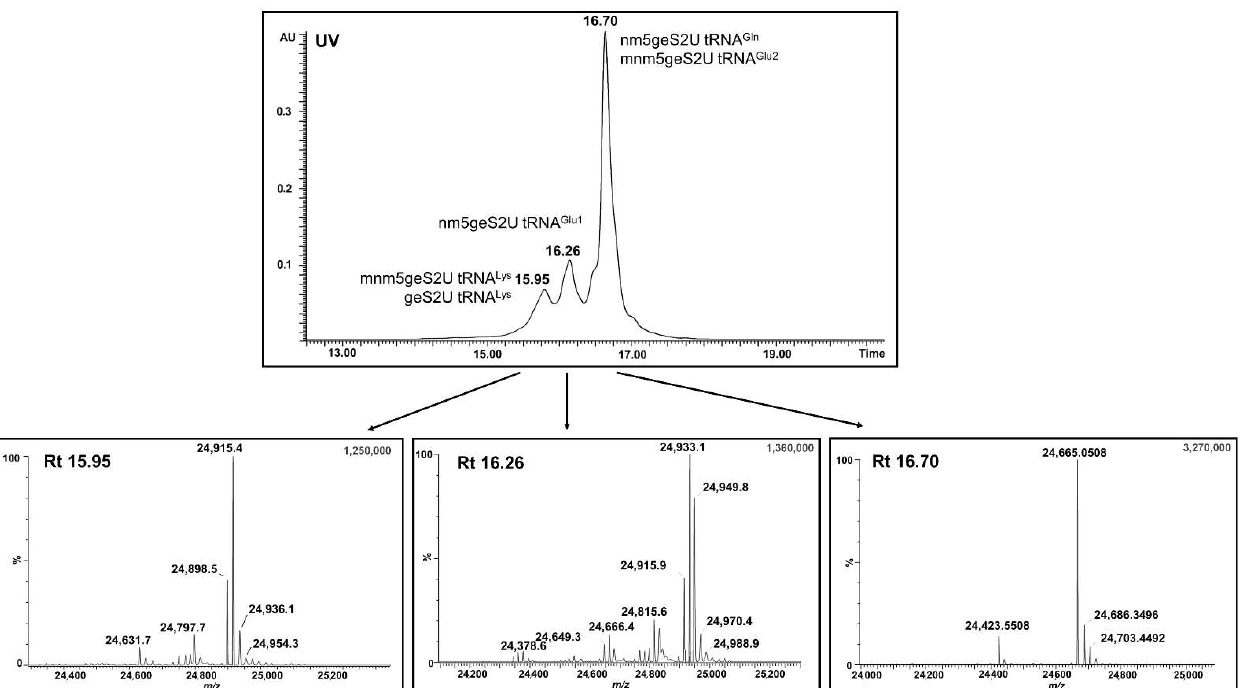
Figure 4. UPLC-PDA-ESI(-)-MS analysis of the full-length tRNAs that were isolated from the pure MBP–SelU protein. The PDA chromatogram and deconvoluted mass spectra corresponded to specific geranylated tRNAs: e.g., mnm5geS2U–tRNA Lys (Rt 15.95 min), nm5geS2U–tRNA Glu (Rt 16.26 min), nm5geS2U–tRNA Gln , and mnm5geS2U–tRNA Glu2 (Rt 16.70 min).